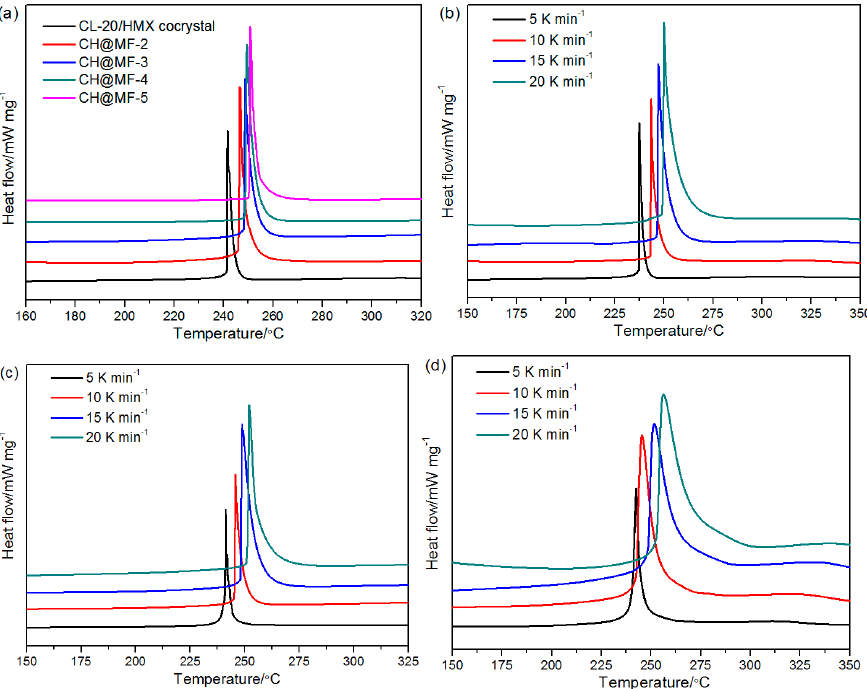
Figure 8. DSC curves of the CL-20/HMX cocrystal and CH@MF composites with a heating rate of 10 ◦ C/min ( a ); DSC curves at different heating rates for CH@MF–2 ( b ), CH@MF–3 ( c )